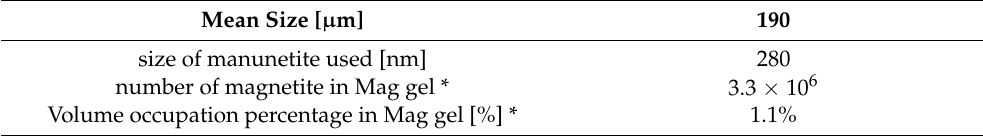
Table 2. Properties of Mag